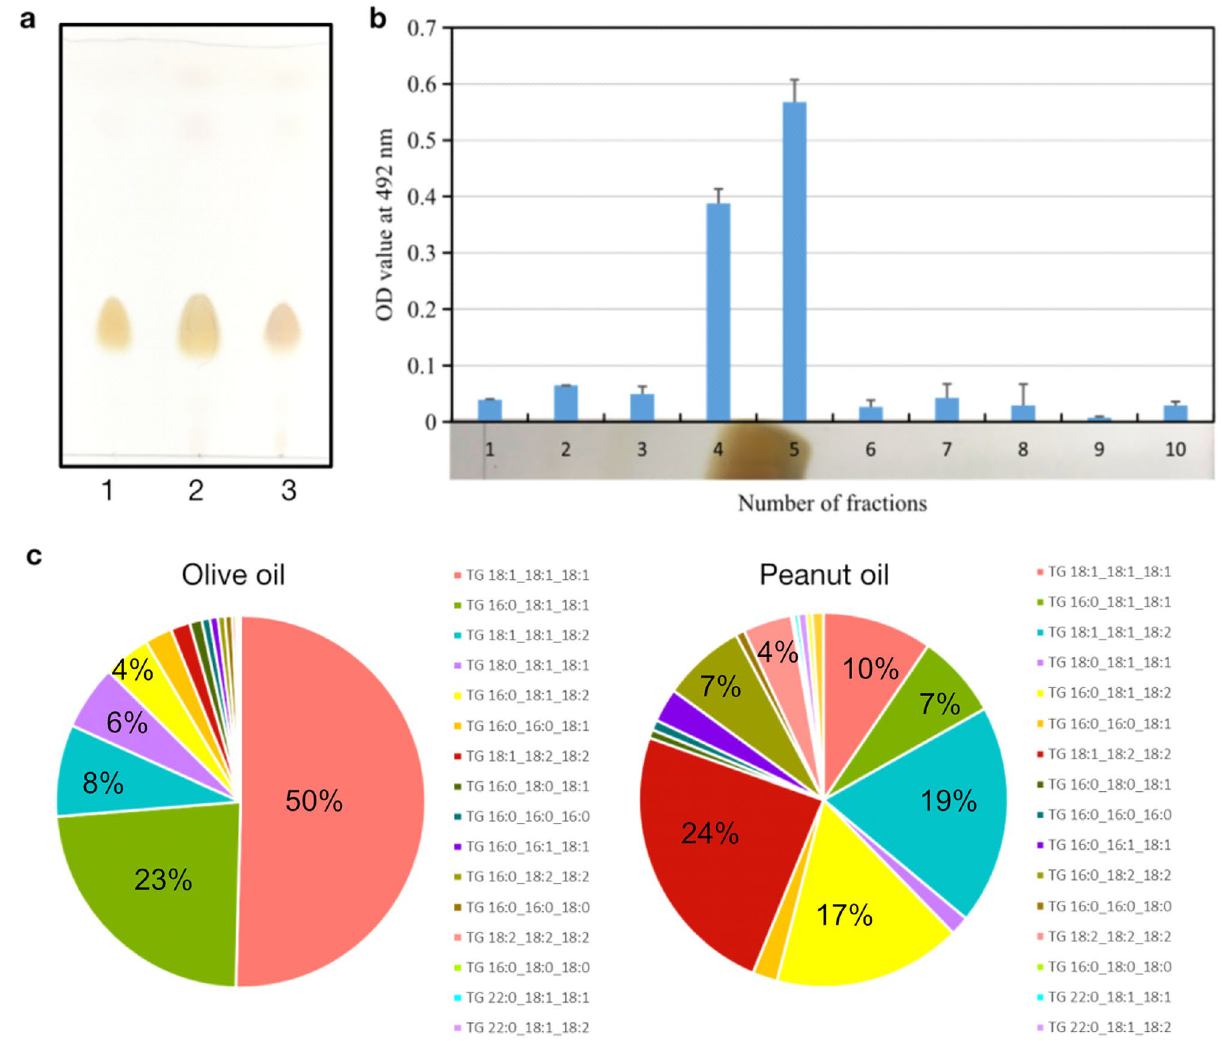
Figure 2. Purification of the immunoreactive substance in the peanut extract. ( a ) The immunoreactive substance was purified using a silica gel column chromatography (Ethyl acetate-Hexane 1:9 v/v), and analyzed using TLC. The samples shown in the figure are: (1) olive TAGs (control), (2) mixture of 1 and 3, and (3) the purified immunoreactive substance in the peanut extract. For the purified peanut extract, a major single spot appeared on the TLC, whose migration matched that of the olive (control) TAGs. ( b ) The immunoreactive activity (i.e., melanin formation) was recovered from the TLC spot. Each of the ten sections of silica layer as shown in the bottom panel was curved and re-extracted to examine the immunoreactivity. As shown in the chart (top panel), the immunoreactivity co-migrated with the spot. The y-axis of the top panel represents the OD value (492 nm) of silkworm hemolymph was measured 3 h after sample injection. The mean value and the standard deviation obtained from duplicate measurements are shown in the chart. (c) Fatty acid compositions were determined as described in “Materials and Methods”. Each combination of three fatty acid moieties were color-coded as demonstrated in the legend. For example, ‘TG 18:1_18:1_18:1’ represents a TAG with three oleic acid moieties, and ‘TG 16:0_18:1_18:1’ represents a TAG with a palmitic acid and two oleic acid triacylglycerol. The purified peanut extract showed a single spot, whose migration matched that of the olive oil sample (Fig. 2a). We further confirmed that the substance in the TLC spot shows the immunoreactivity, when re-extracted from the TLC plate, in silkworms (Fig. 2b). These results suggest that the immunoreactive substance in the peanut oil is TAGs. We then analyzed the fatty acid composition of the extracted TAG sample. As shown in Fig. 2c, the majority of olive TAGs contained 18:1/18:1/18:1 (i.e., all three fatty acid moieties were oleic acid), while that of peanut TAGs contained 18:1/18:2/18:2 (i.e., an oleic acid moiety and two linoleic acid moieties),